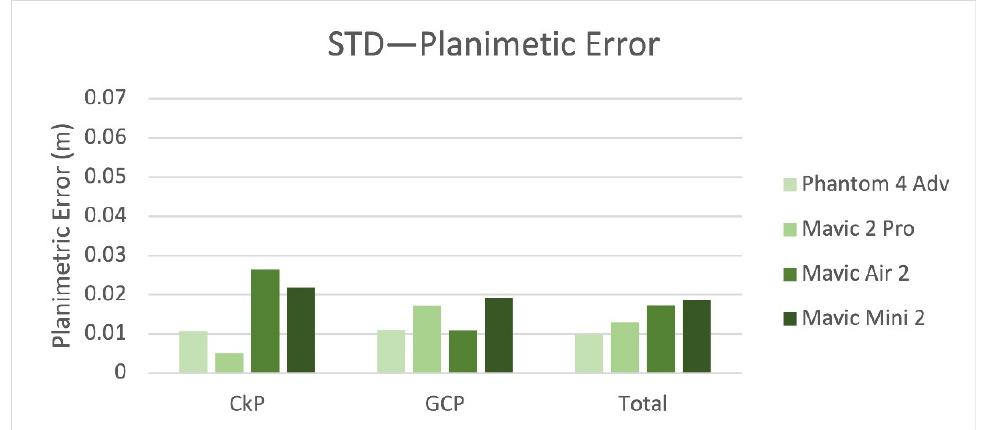
Figure 16. Chart of standard deviations calculated for the planimetric error.